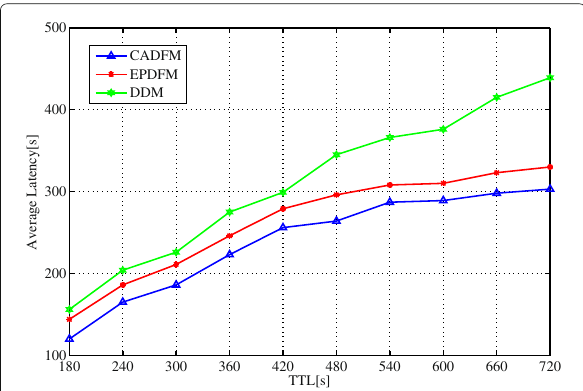
intelligent technologies such as machine learning and search technologies in edge network for smart transmis- sion and IoT applications. For example, mobile edge com- puting will play a vital role in future connected vehicular system in which vehicles exchange information among each other via the help of mobile edge nodes available on the road. The information obtained from the knowledge layer, e.g., the trustworthiness between devices, could be used to facilitate the communications among IoT devices, to realize a trustworthy and reliable data transmission. Last but not the least, the proposed framework provides a new perspective in understanding the resource allocation problem in future cellular network, which is not available in the